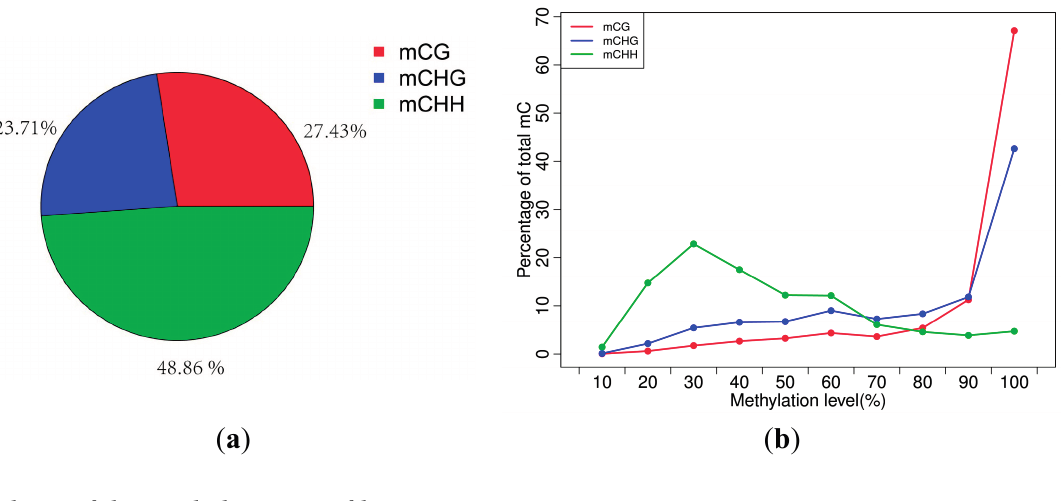
Figure 1. DNA methylation pattern in Betula platyphylla . ( a ) Relative percentages of methylcytosines (mCs) in the sequence contexts of CG, CHG (where H = A, C or T), and asymmetric CHH; ( b ) Distribution of methylation level of mCs in each sequence context. Only mCs covered by at least five reads were used to calculate the methylation level. The x -axis was defined as the percentage of reads showing mCs at a reference cytosine site. The y -axis indicates the fraction of total mCs calculated within bins of 10%.